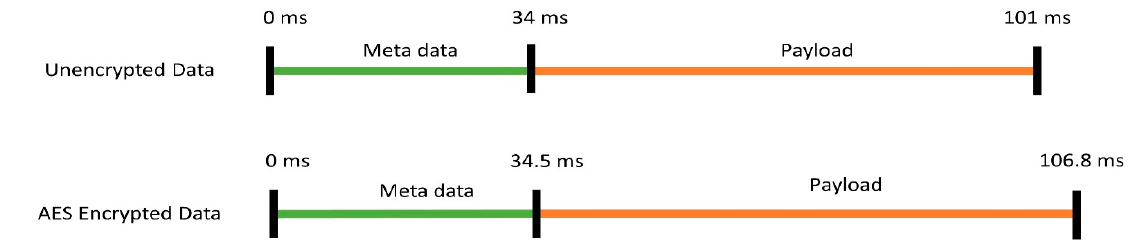
Figure 7. Reception time of the transmitted data packet components.